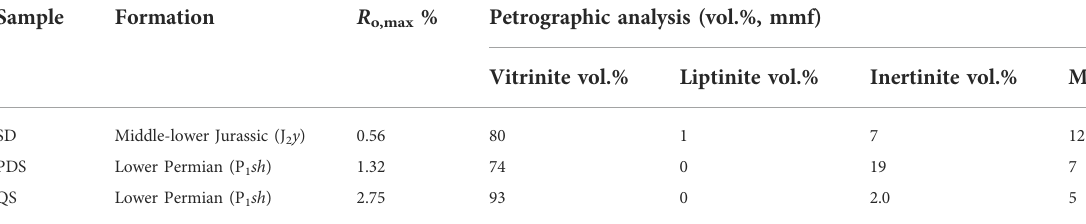
TABLE 2 Petrographic composition data of the sampled coals.